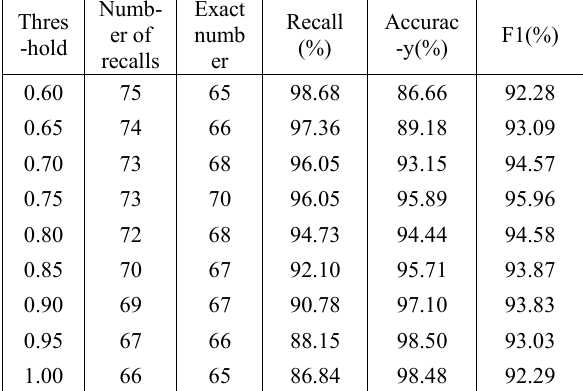
Table 1 . Recognition results of entities with the same name under different